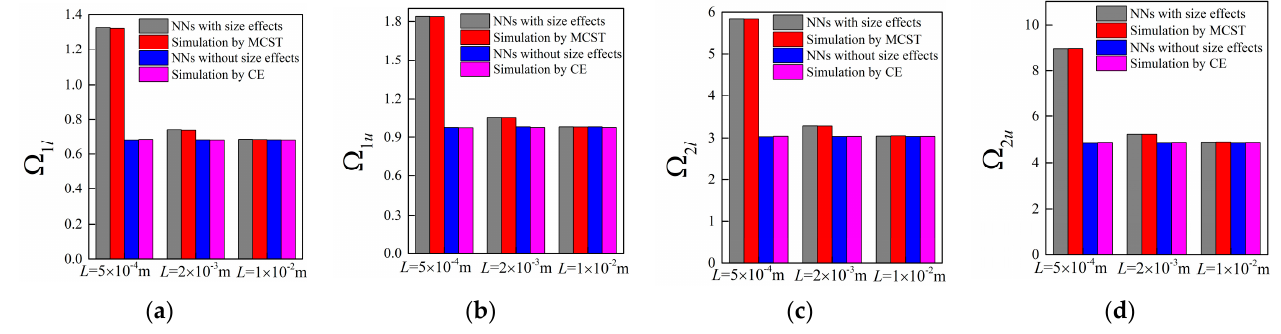
Figure 8. The predictions for bounding frequencies of size-dependent and size-independent band gaps of random example 4: ( a , b ) the lower and upper boundary of first band gap; ( c , d ) the lower and upper boundary of the second band gap.